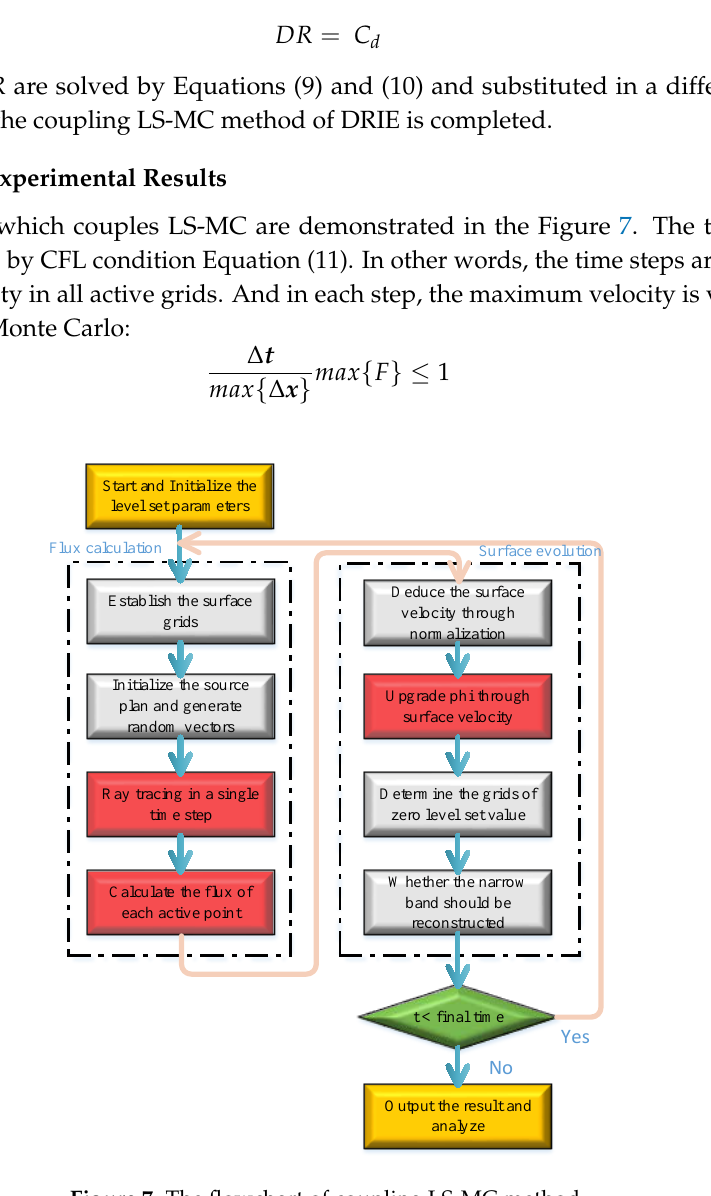
Figure 7. The flowchart of coupling LS-MC method.